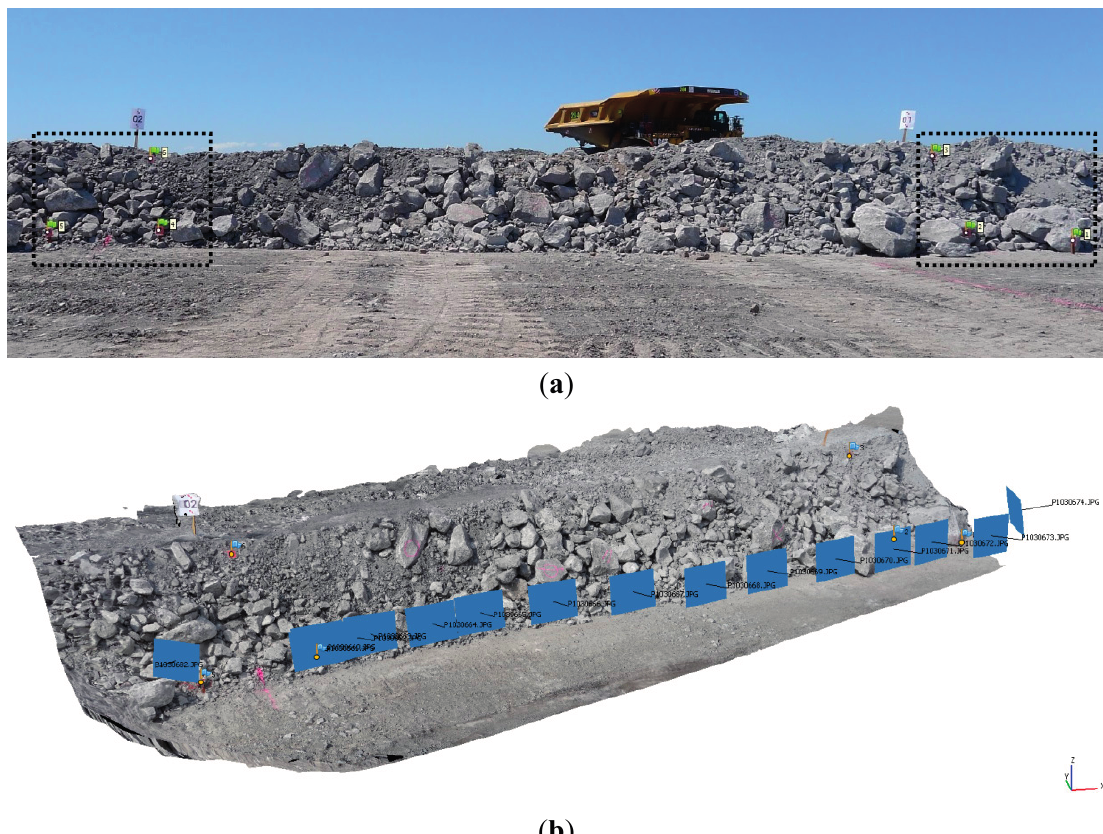
Figure 1. In situ full-scale tests: ( a ) typical berm with ground control points (GCP); ( b ) corresponding typical parallel image